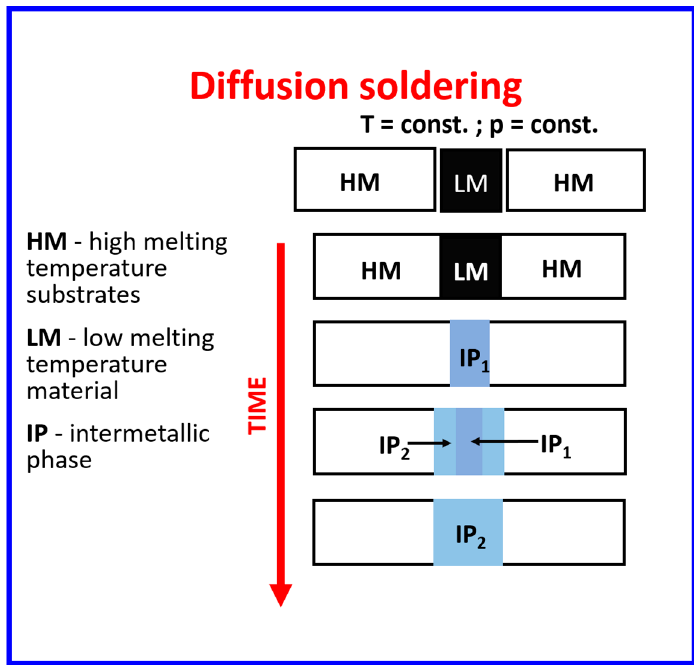
Figure 1. Schematic of diffusion soldering process [22].